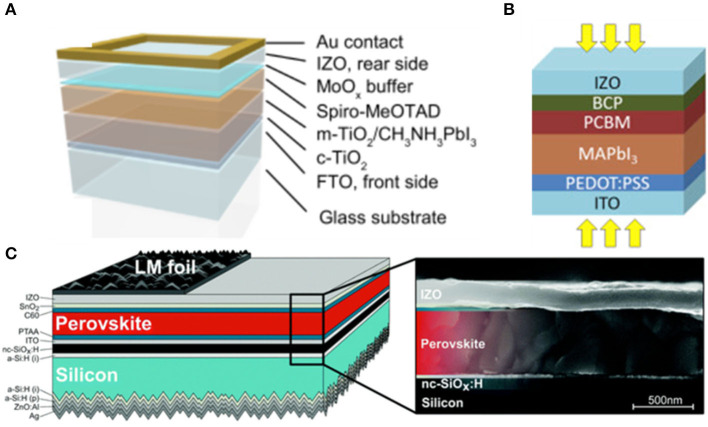
(A) Schematic illustration of a typical PVSK solar cell structure with a transparent rear electrode and Au contact (reproduced from ref. 23, copyright 2015, Elsevier). (B) Structure of semitransparent inverted PVSK solar cells (reproduced from ref. 24, copyright 2015, Elsevier). (C) Tandem solar cell device schematics of the experimentally realized architecture and SEM cross section image of the top cell with the layers as indicated (reproduced from ref. 25, copyright 2018, Royal Society of Chemistry).